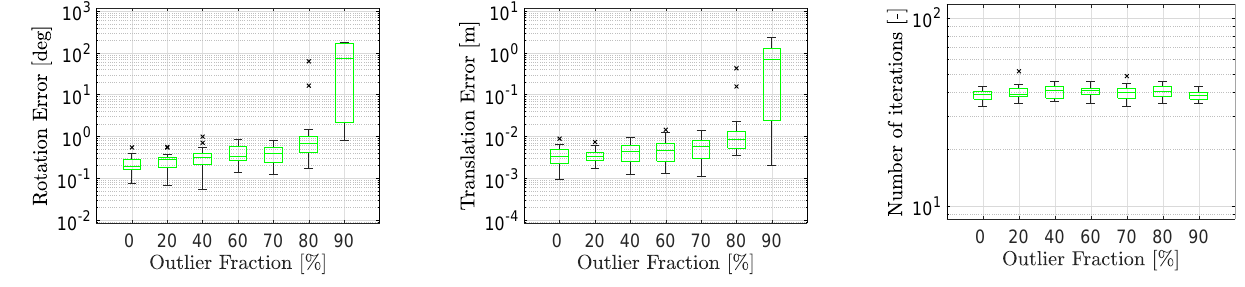
Figure 5: Box plots showing rotation errors, translation errors, and number of iterations used for Primitive registration using the Aeroplane-2 mesh model in the PASCAL3D+ data set, solved using Dynamical Pose Estimation with Graduated Non-Convexity.